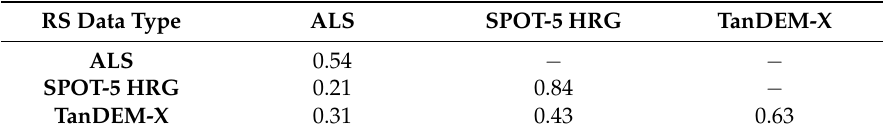
Table 6. Average correlation for the residuals of mean height.